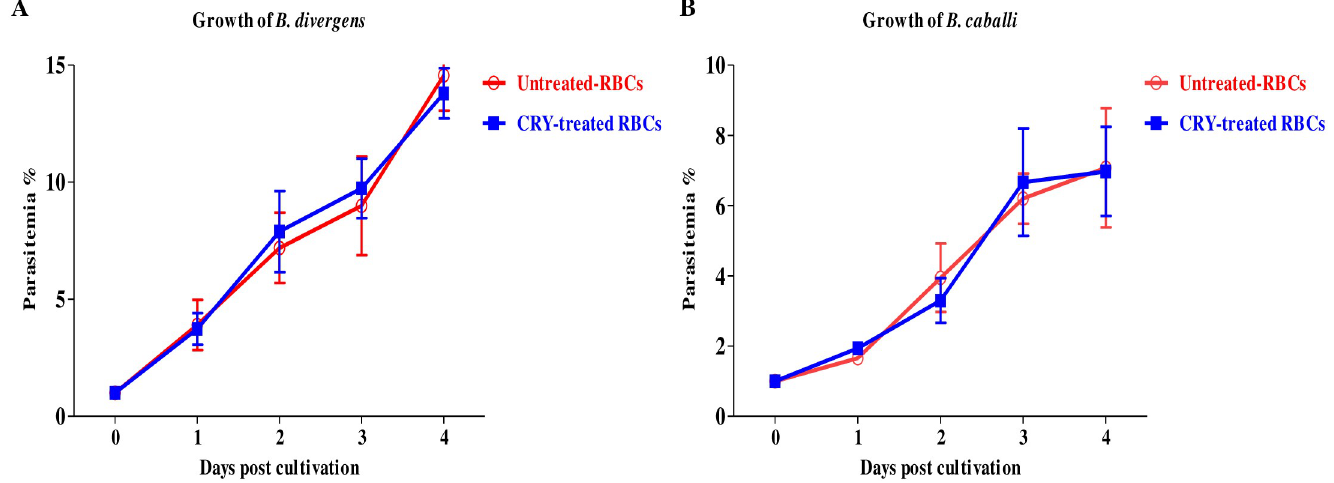
Fig 2. Growth of B . divergens with CRY-treated bovine RBCs (A) and growth of B . caballi with CRY-treated horse RBCs (B).